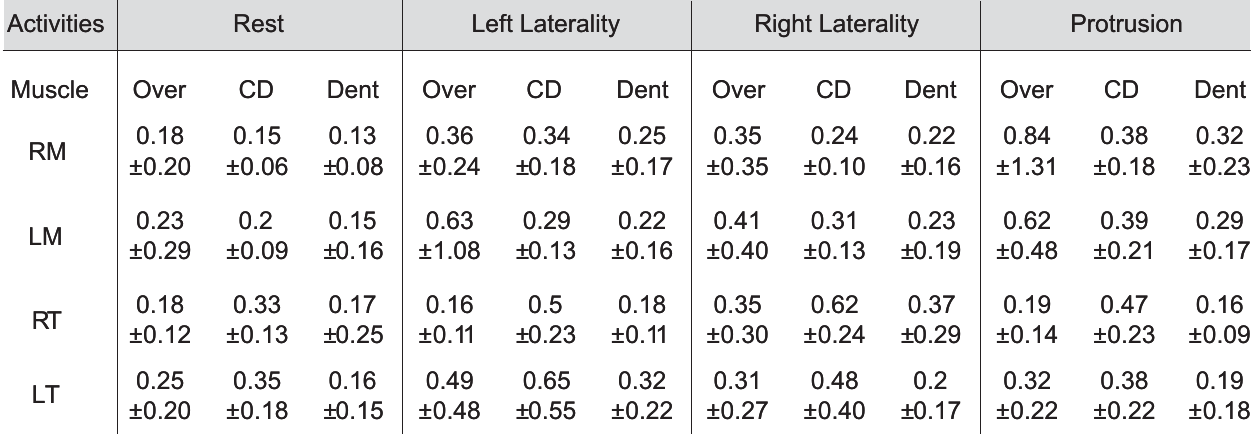
Table 1. Normalized electromyographic data (RMS). Averages and standard deviation (SD) of masseter muscle activity (RM and LM) and temporalis muscle activity (RD and LT) while at rest (RP), left laterality (LL), right laterality (RL) and protrusion (PRO) of overdenture wearers (Over), complete denture wearers (CD) and dentate